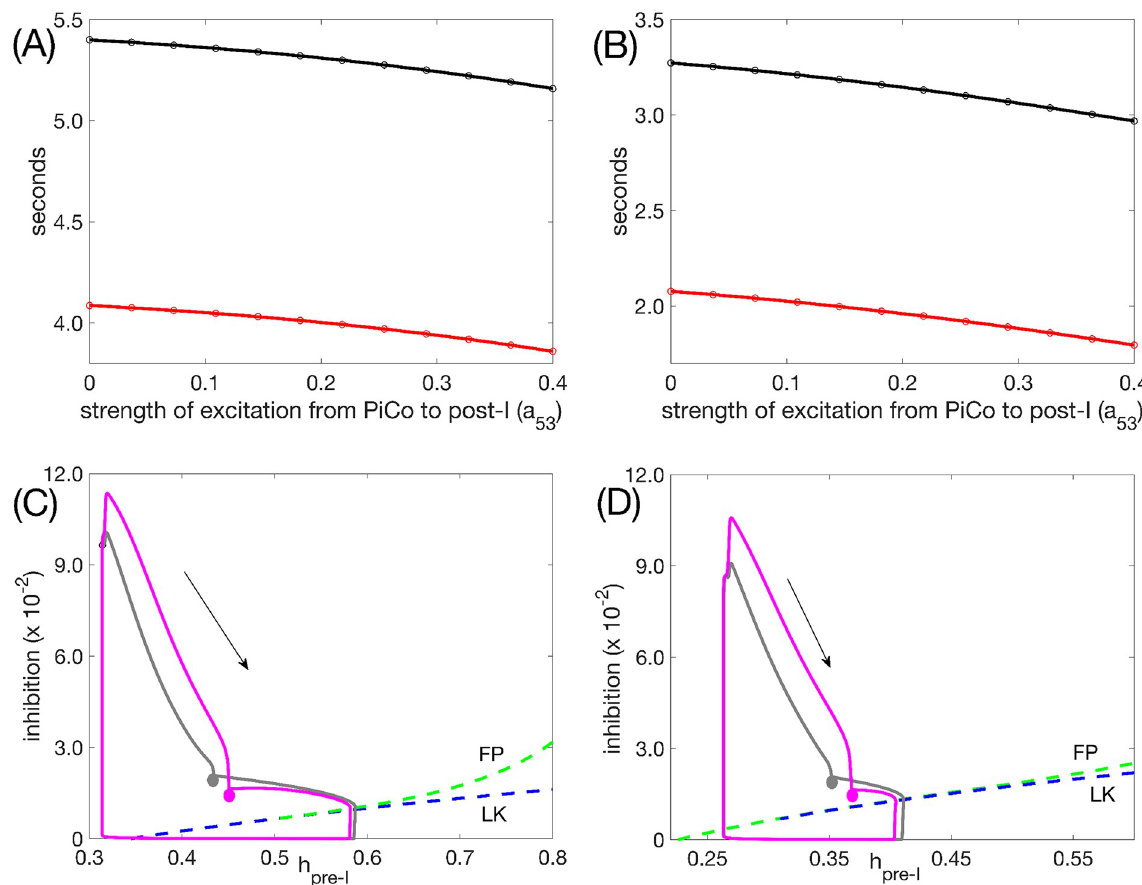
Fig 12. Effect of increasing drive from PiCo to the post-I unit ( a 53 ) on respiratory period. (A) Period (black) and expiratory phase duration (red) for c 11 = − 0.03 (pre-I unit intrinsically oscillatory). (B) Period (black) and expiratory phase duration (red) for c 11 = 0.01 (pre-I tonic). Note that the entire change in period is captured by the change in expiratory phase duration in both (A) and (B). (C) Trajectories projected into the slow phase plane for the pre-I unit with c 11 = − 0.03 for a 53 = 0 (without PiCo activity, grey) and a 53 = 0.4 (with PiCo activity, magenta). The curves of fixed points (green, FP) and left knees (blue, LK) for the pre-I unit dynamics are also shown. (D) Trajectories projected into the slow phase plane for the pre-I unit with c 11 = 0.01 for a 53 = 0 (grey) and a 53 = 0.4 (magenta). FP and LK as in (C). In both (C) and (D), the projected trajectories reach the points marked with circles at the start of the aug-E phase. The arrow indicates the direction of flow.